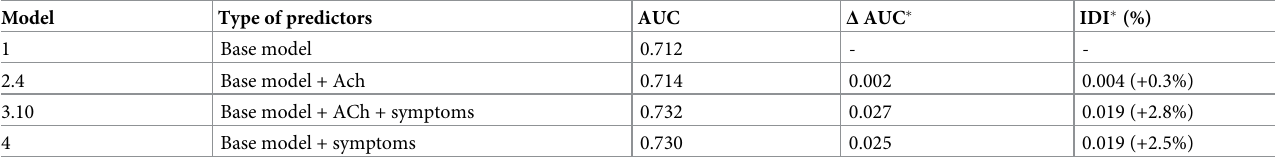
Table 4. Increase in